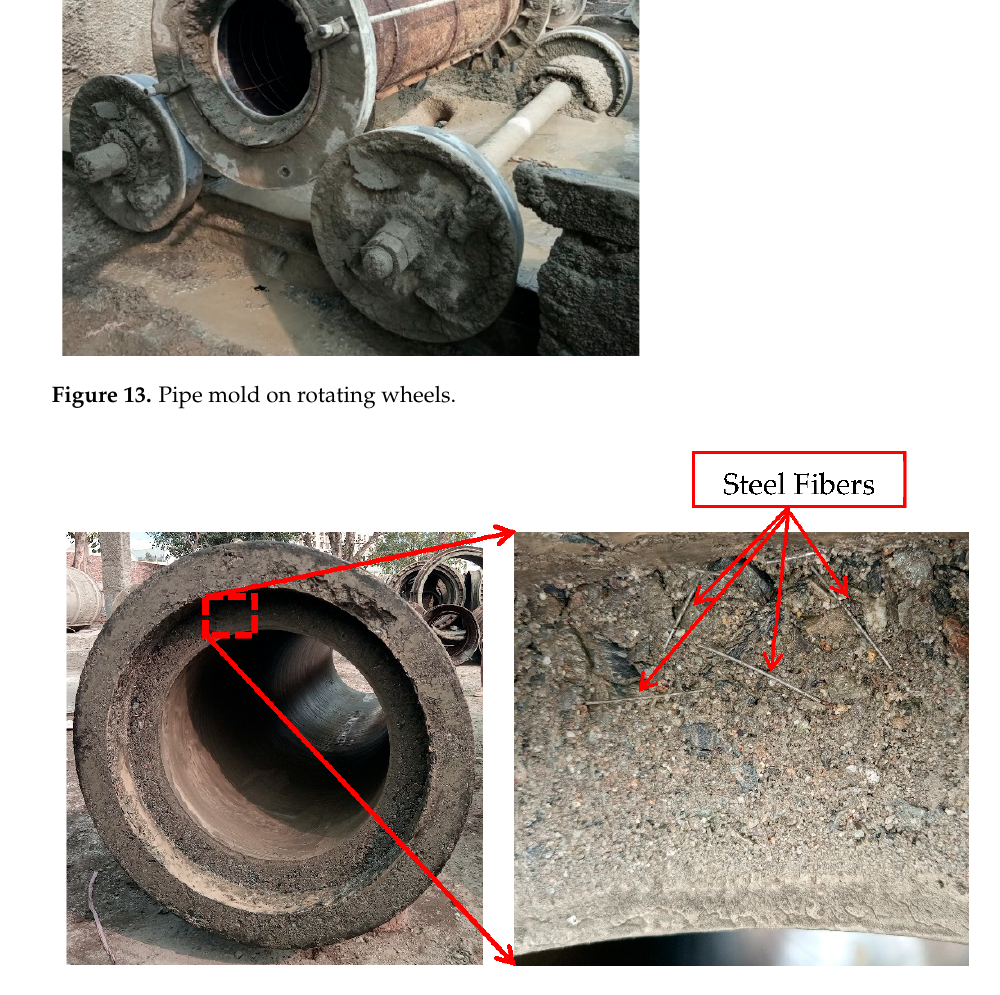
Figure 13. Pipe mold on rotating wheels.